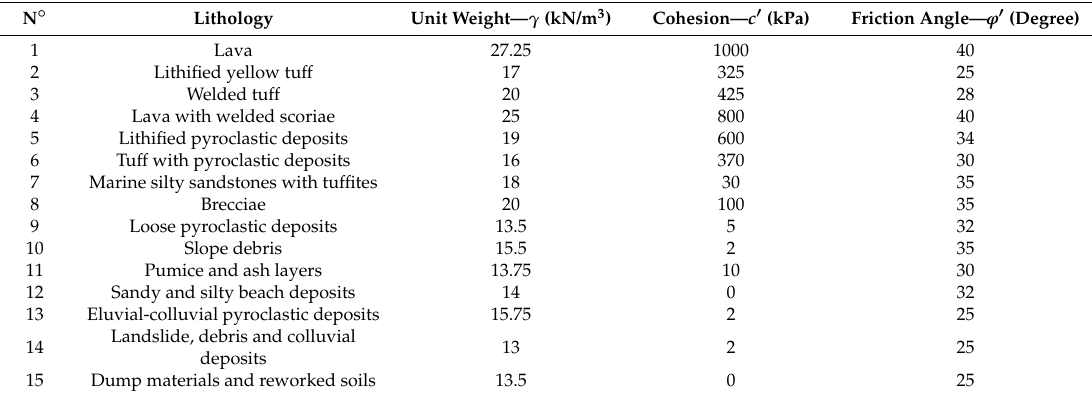
Table 1. Lithological units (for the reference number see Figure 5a) and main geotechnical parameters